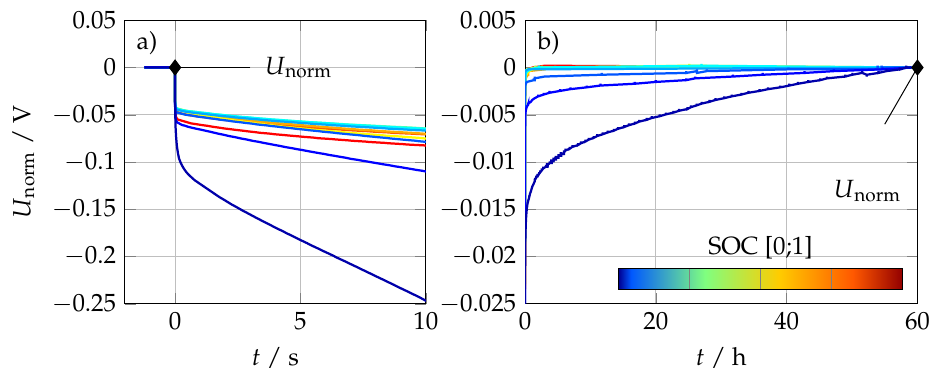
Figure 1. Results of time-domain measurements for all SOC steps between 100% SOC and 0% SOC. ( a ) 1C discharge pulse for 10s. The voltage is normalized on the starting voltage for every SOC. − ( b ) Relaxation period of T relax = 60h. The voltage is normalized on the last data point of the relaxation period for every SOC. Note that the voltage was not totally relaxed after 60h for low